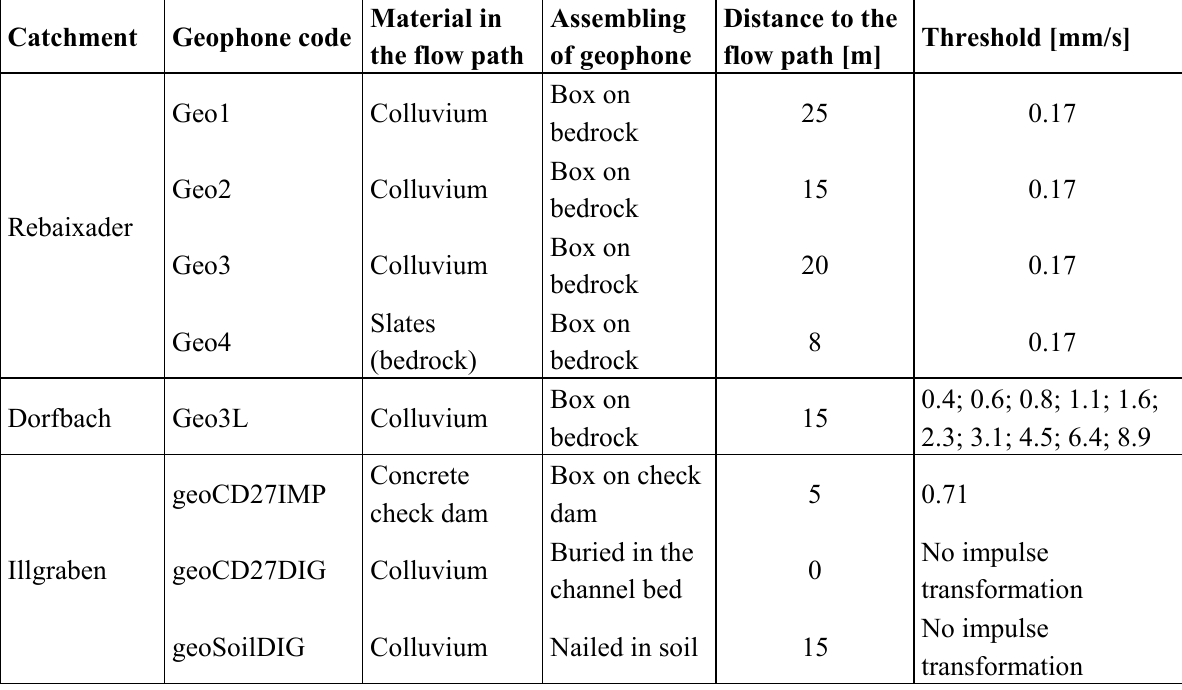
Table 1. Main characteristics of the location of the geophones analyzed in this